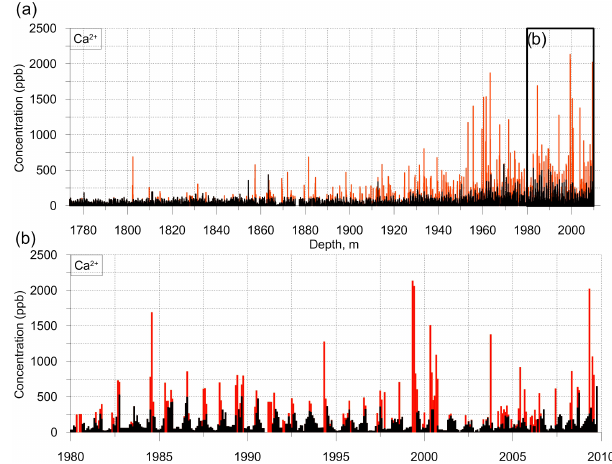
Figure 4. (a) Total (red) and background (black) Ca 2 + concentra- tions (ppb) in Elbrus ice core samples. The full record (a) and the upper section of the ice core (b) are shown. Note that the back- ground concentration values reflect removal of samples which were found to have been influenced by large dust deposition